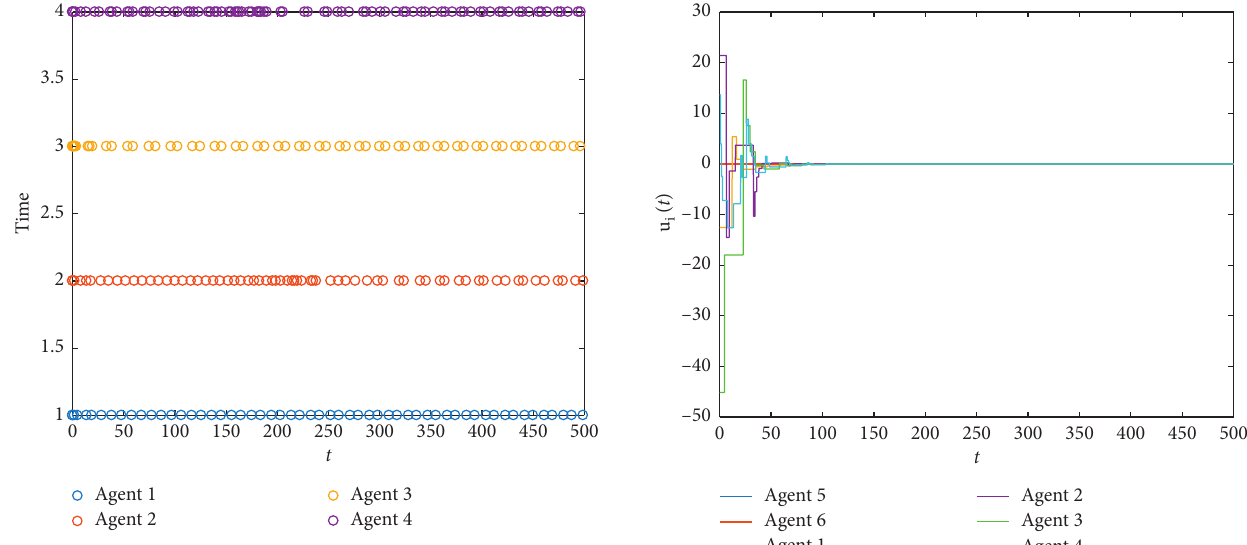
Figure 3: The event-triggered time for tracking control.